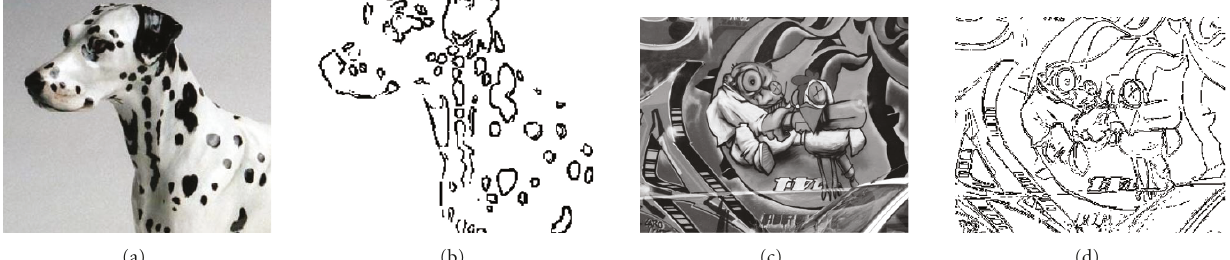
Figure 4: Relevant orientations estimation.